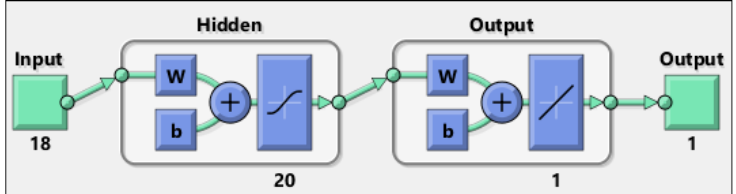
Figure 5. Artificial neural network architecture from MATLAB software (R2022a).